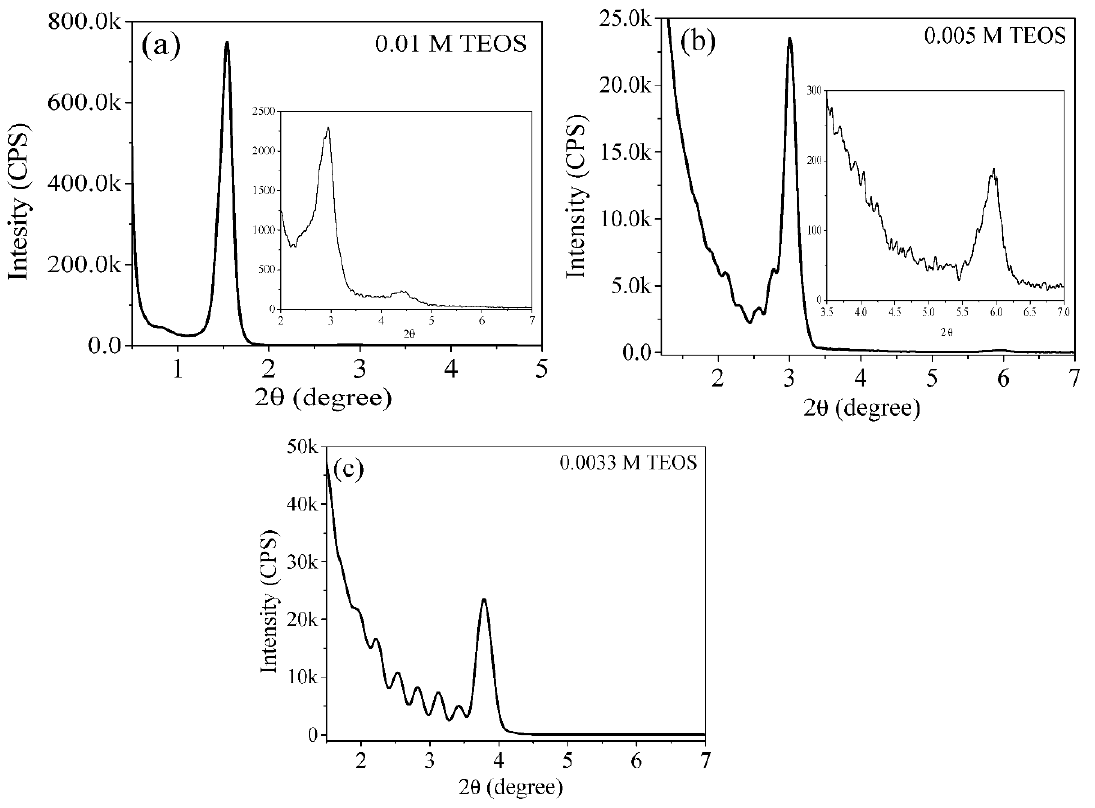
Figure 1. XRD graphs of mesoporous silica thin films using ( a ) 0.01 M ( b ) 0.005 M and ( c ) 0.0033 M of TEOS precursor. Inset of figure ( a ) and ( b ) shows expanded region around the peak for clarity.